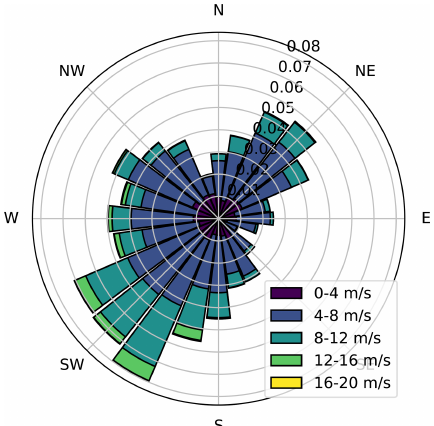
Figure 2. Long-term wind rose for the SMV wind plant at hub height (80m). It was obtained through a correlation process be- tween short-term met-mast measurements on-site and long-term reference wind data (ERA5 reanalysis data). Taken from Simley et al.